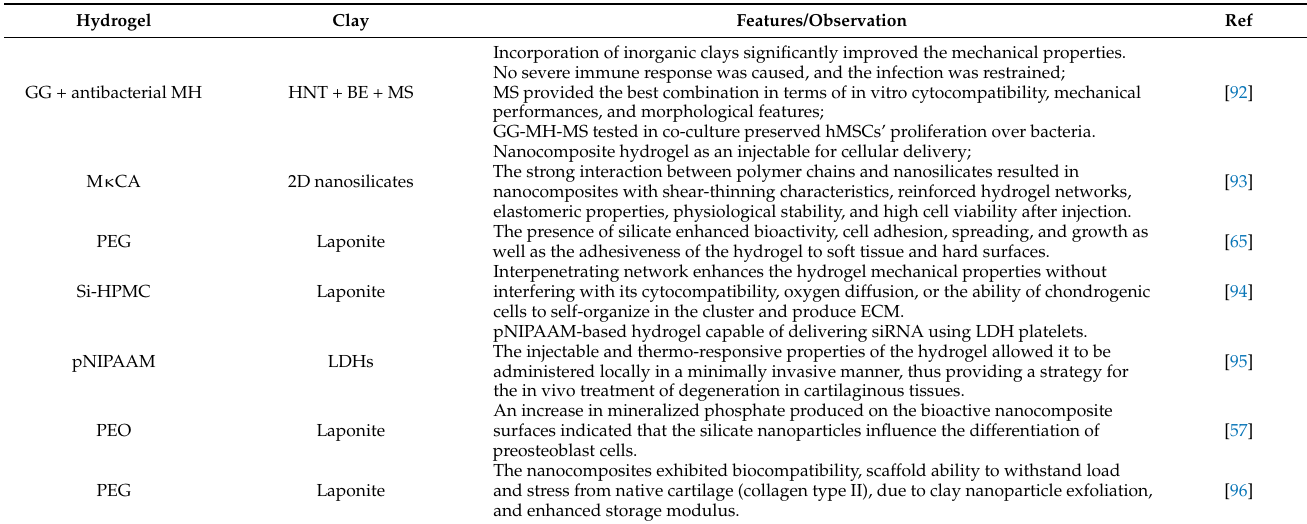
Table 3. Clay nanoparticles in hydrogel nanocomposites for cartilage